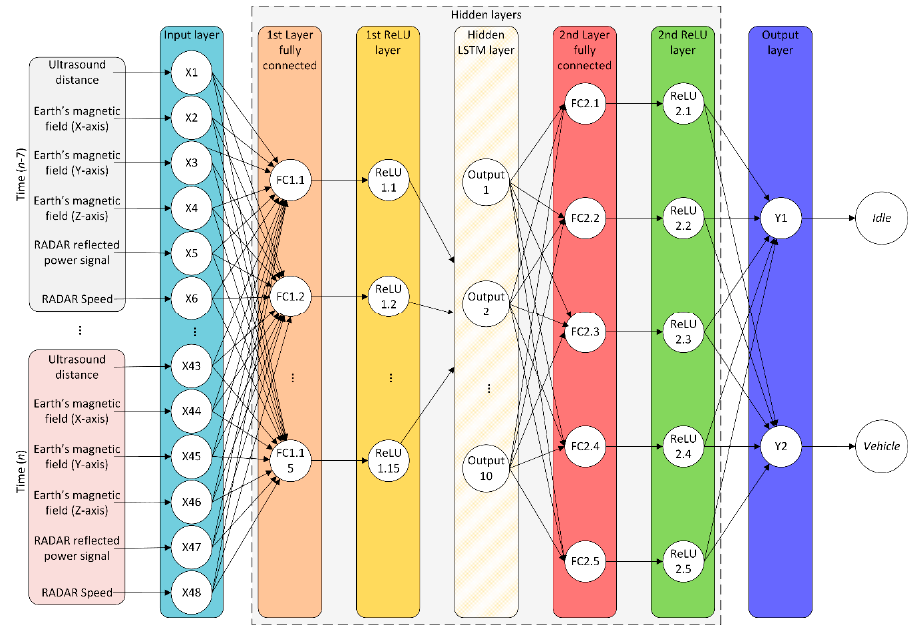
Figure 4. Neural network structure for the DRL used.